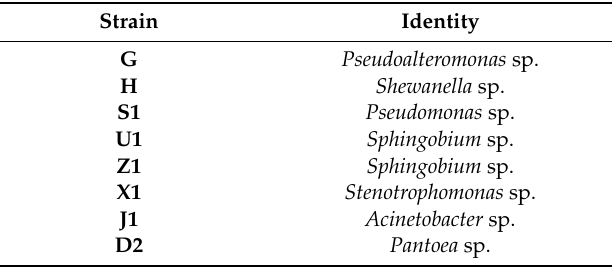
Table 1. Genera of the bacterial isolates at pH 6 based on their 16S sequences. Strain Identity G Pseudoalteromonas sp. H Shewanella sp. S1 Pseudomonas sp. Pantoea sp.